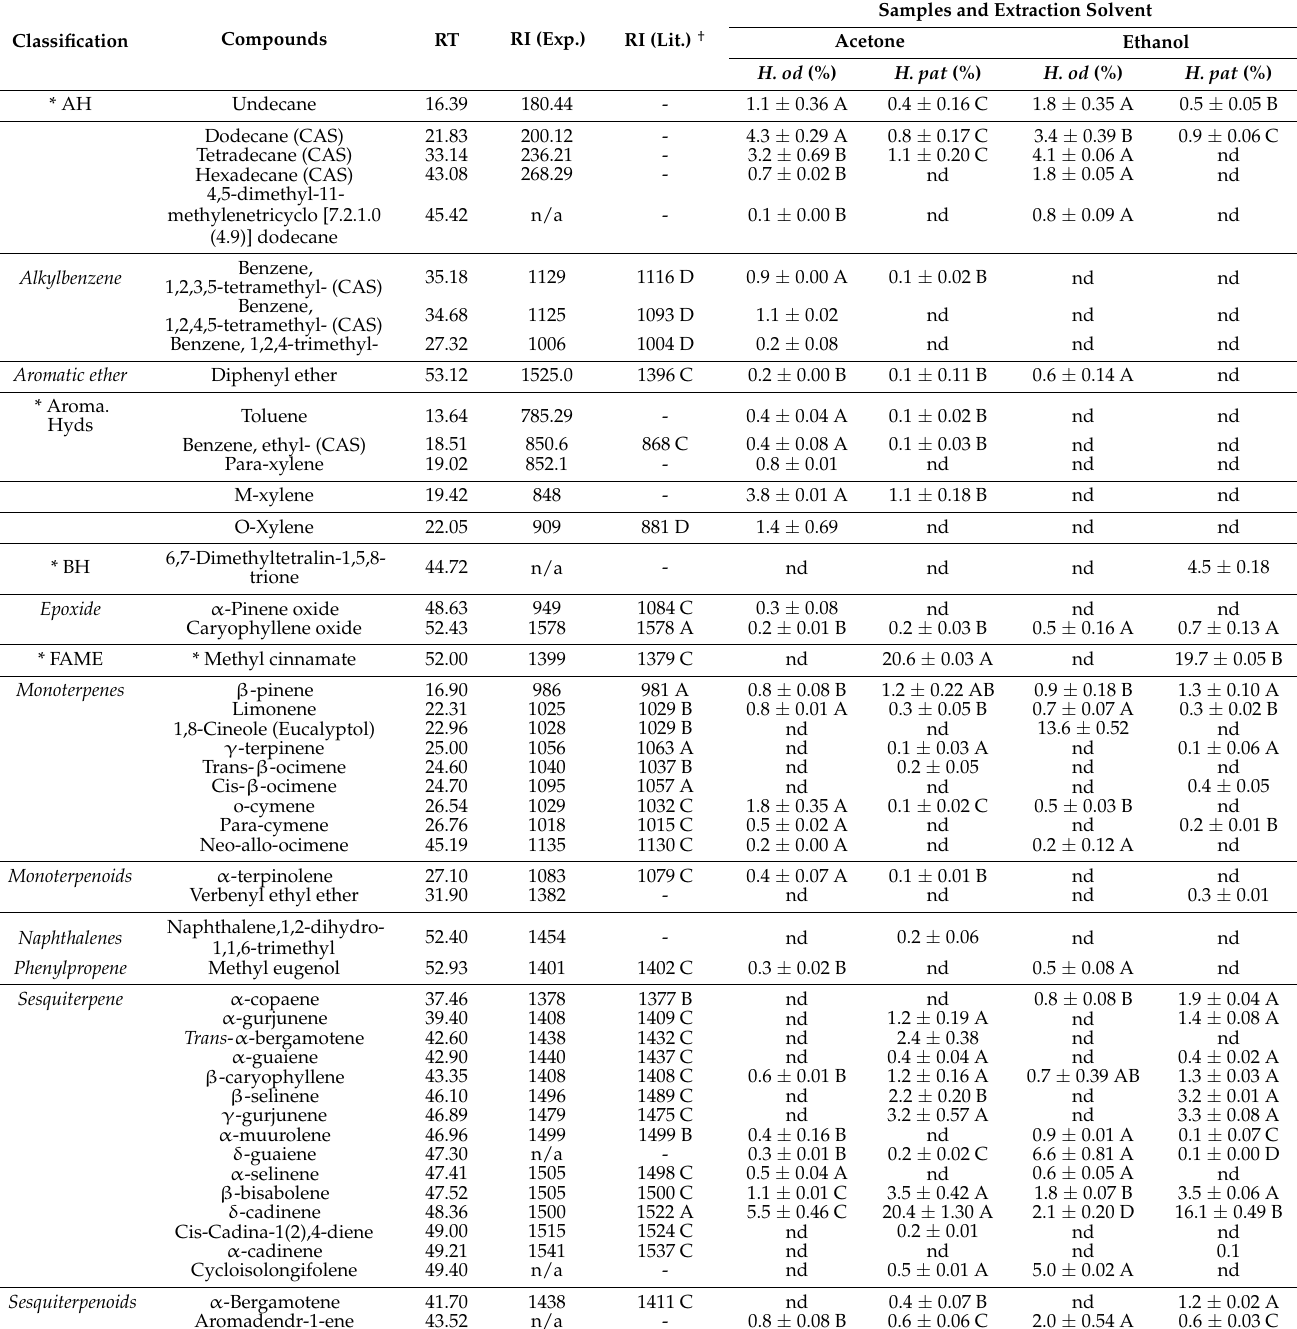
Table 2. Relative percentage composition of volatile compounds isolated from crude acetone and ethanol extracts of H. odoratissimum (H. od) and H. patulum (H. pat) from Western Cape, South